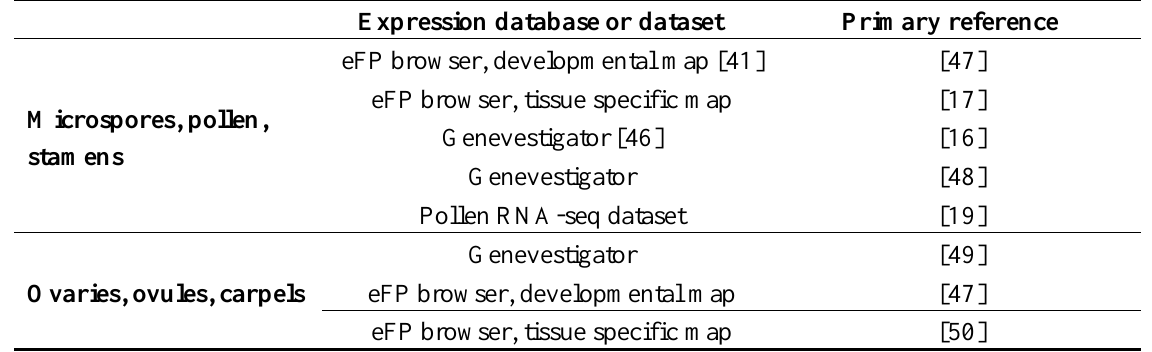
Table 2. Multiple microarray studies as well as RNA-seq document PIRL6 expression in gametophytes and reproductive